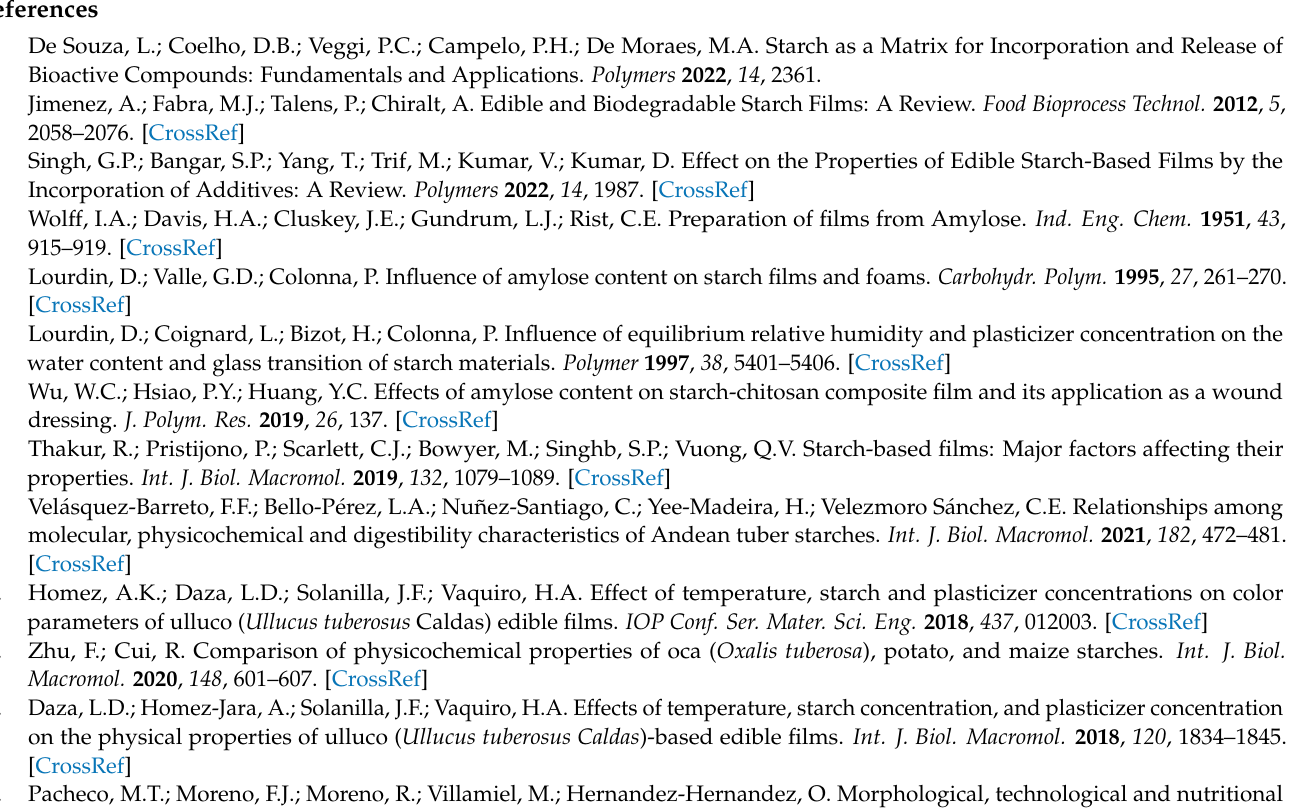
Figure S2: Micrographs of starch films extracted from each of the Andean tubers analyzed after addi- tion of mouthwash to each one, in reflection using white light transmission illumination; Figure S3: Atomic force microscopy topography 3D images of 10 × 10 µ m 2 range; Figure S4: Atomic Force Mi- croscopy topography 3D images of 2 × 2 µ m 2 range; Figure S5: Atomic Force Microscopy amplitude (lock-in, error signal) measured in tapping mode on the surface of biofilms extracted from the Andean tubers melloco, mashua, oca, and potato, at different scan